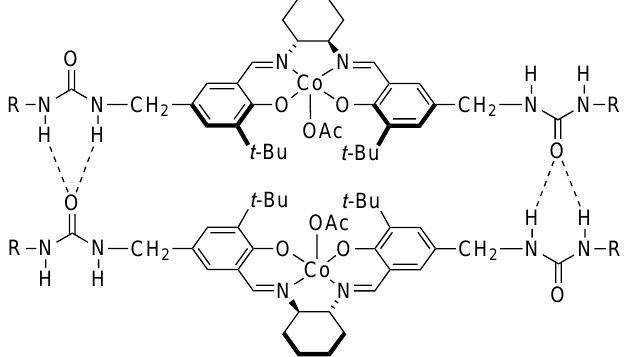
Figure 40. Bis-urea-functionalized Co–salen catalyst 106 , displayed as hydrogen-bonded